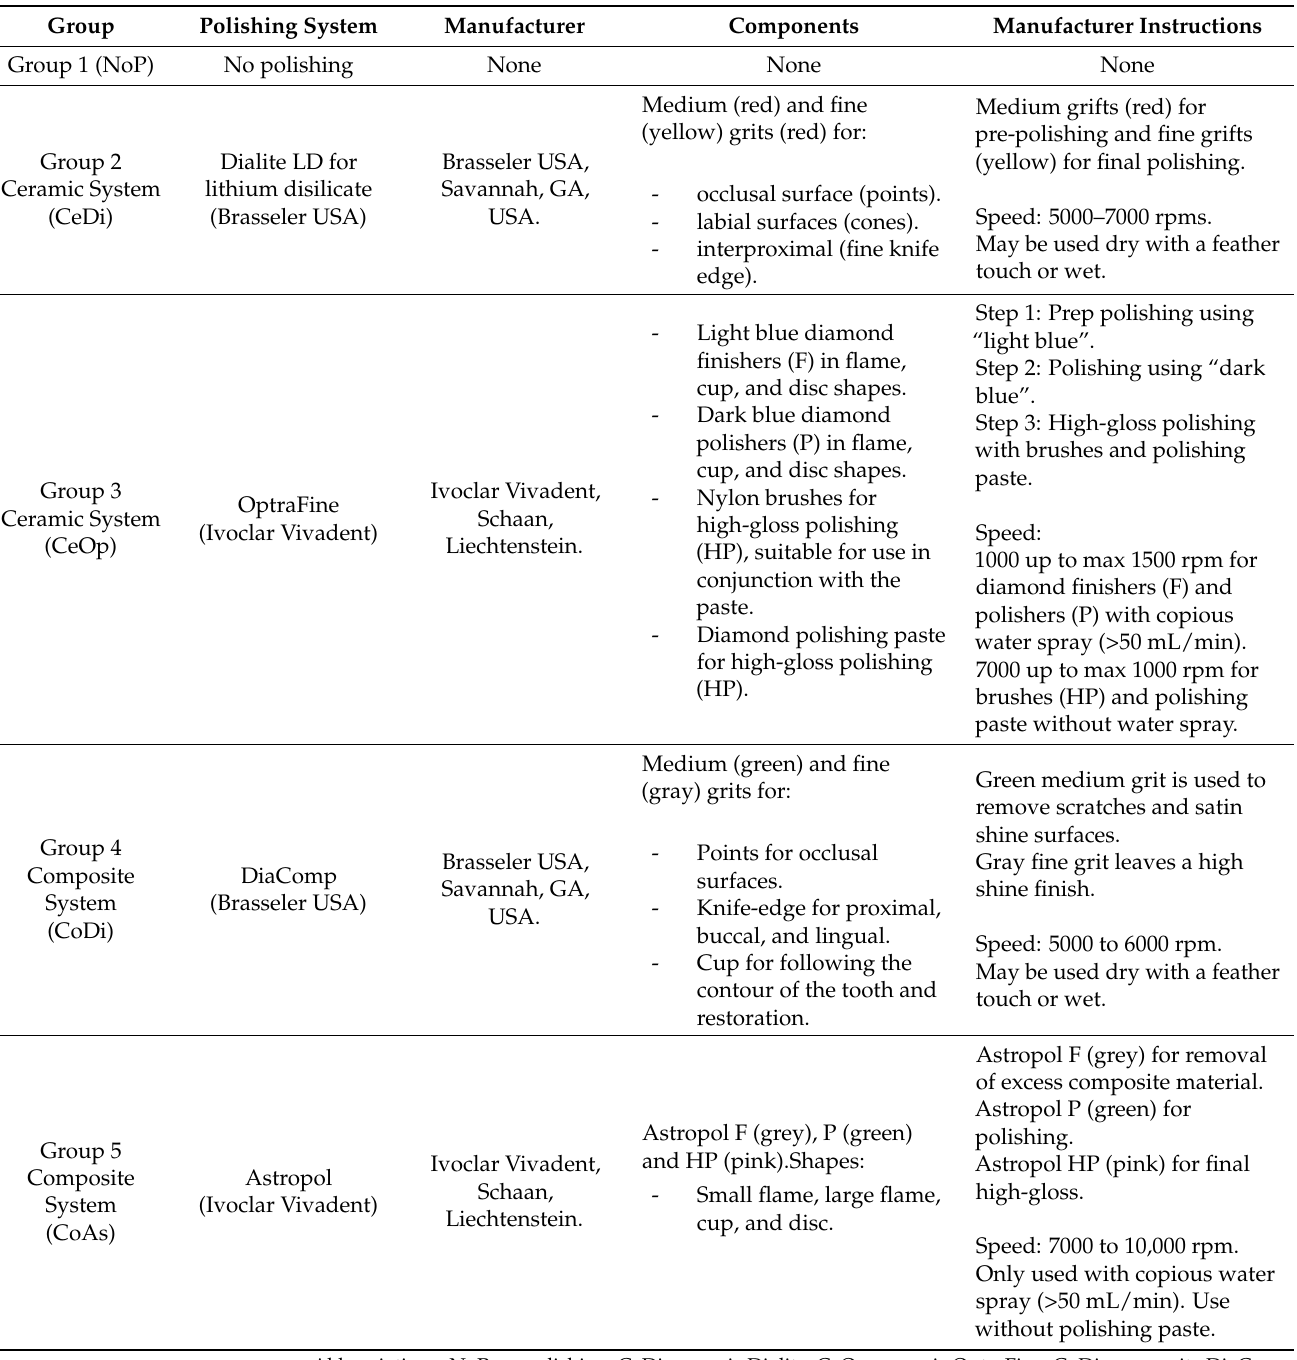
Table 1. Description of polishing systems used in this